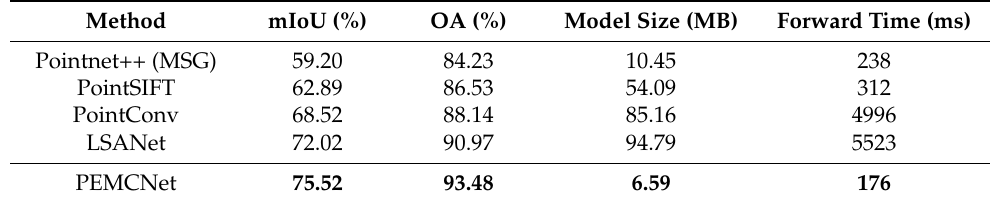
Table 3. Quantitative classification performance of different networks on Semantic3D (reduced-8) dataset.